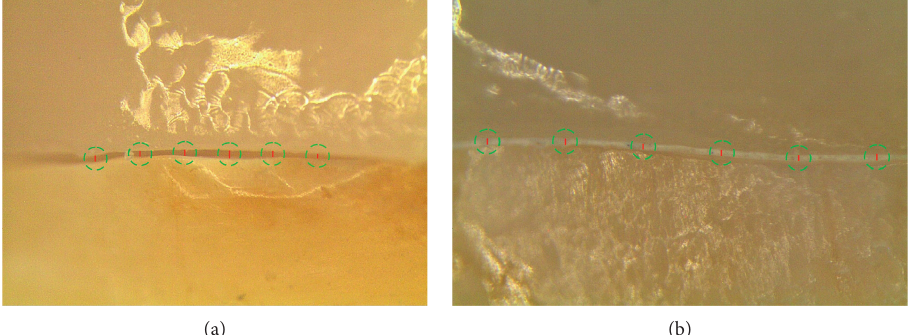
Figure 4: Stereomicroscope photographs of two specimens. (a) Before cementation. (b) After cementation. Red lines show gap/cement layer thickness